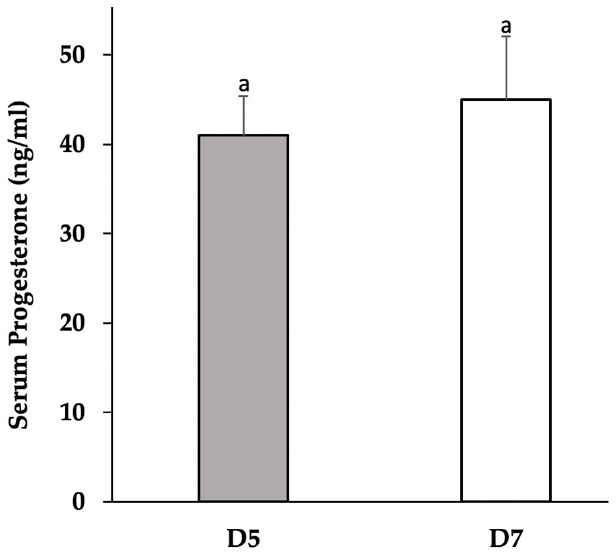
Figure 1. Serum concentrations of progesterone from sows collected on D5 ( n = 4) and D7 ( n = 5) of the estrous cycle. Progesterone did not significantly differ ( a p > 0.05) between days.